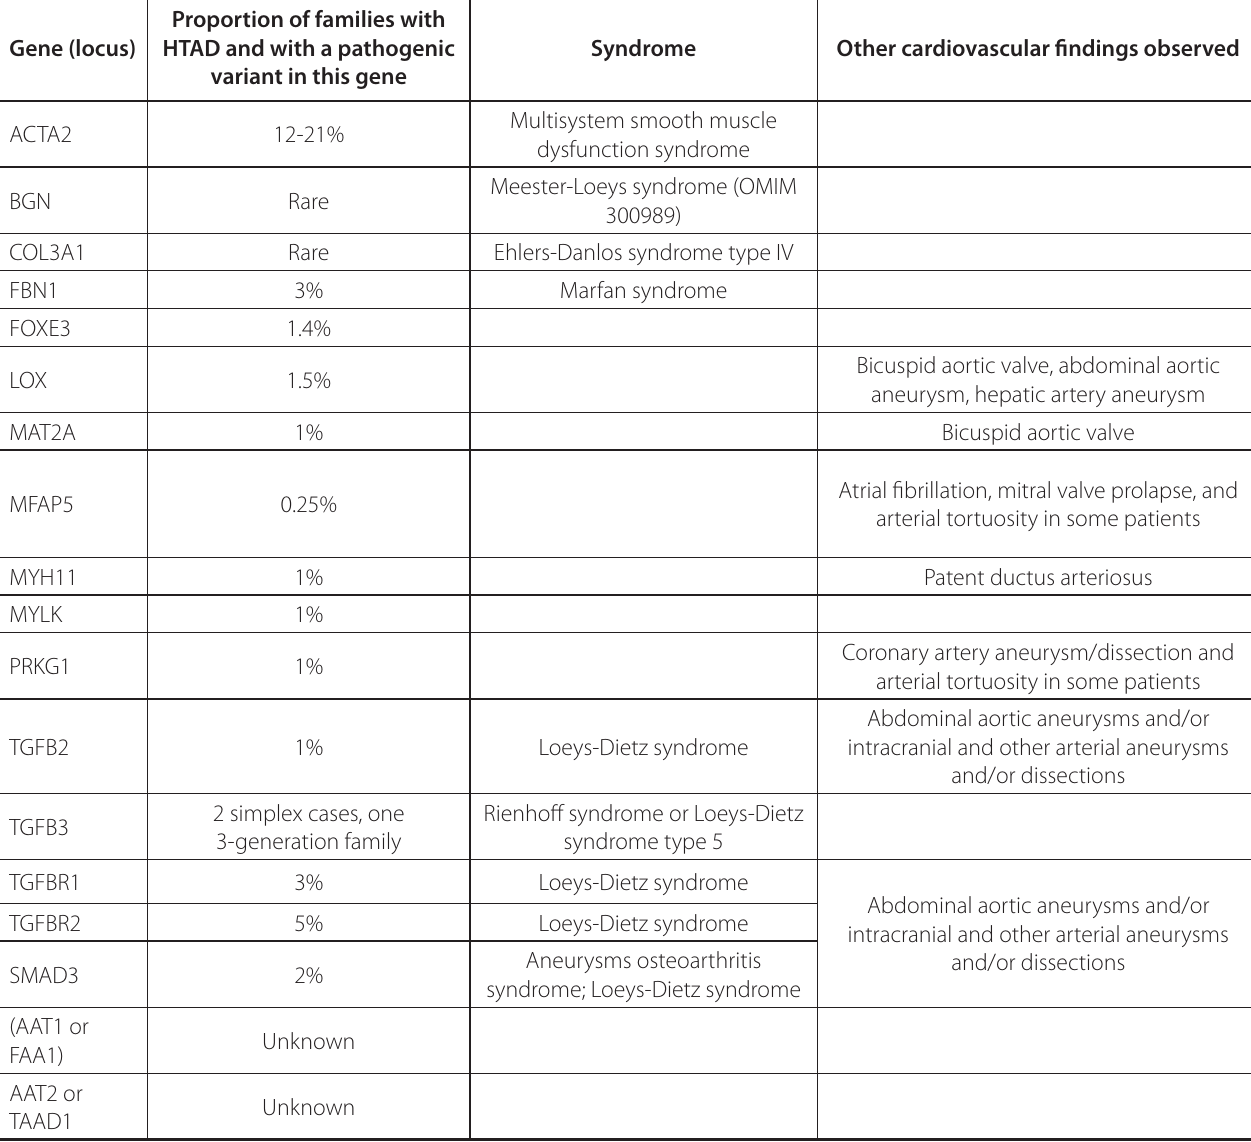
Table 4 . The HTAD genes. Gene